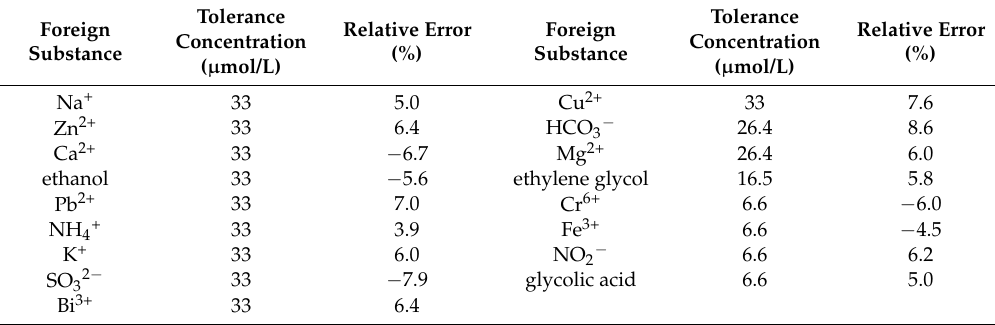
Table 3. Effect of interfering substances on the SERS detection of 0.66 µ mol/L SO 42 − .